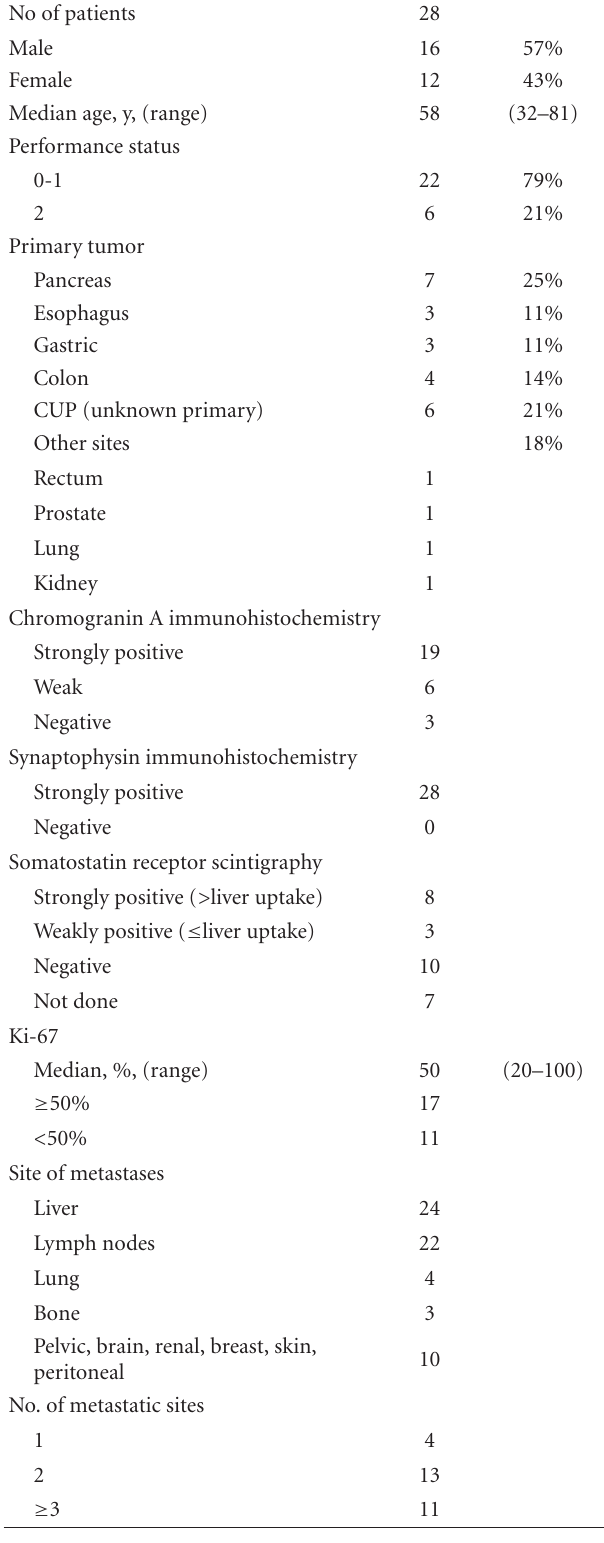
Table 1: Patient